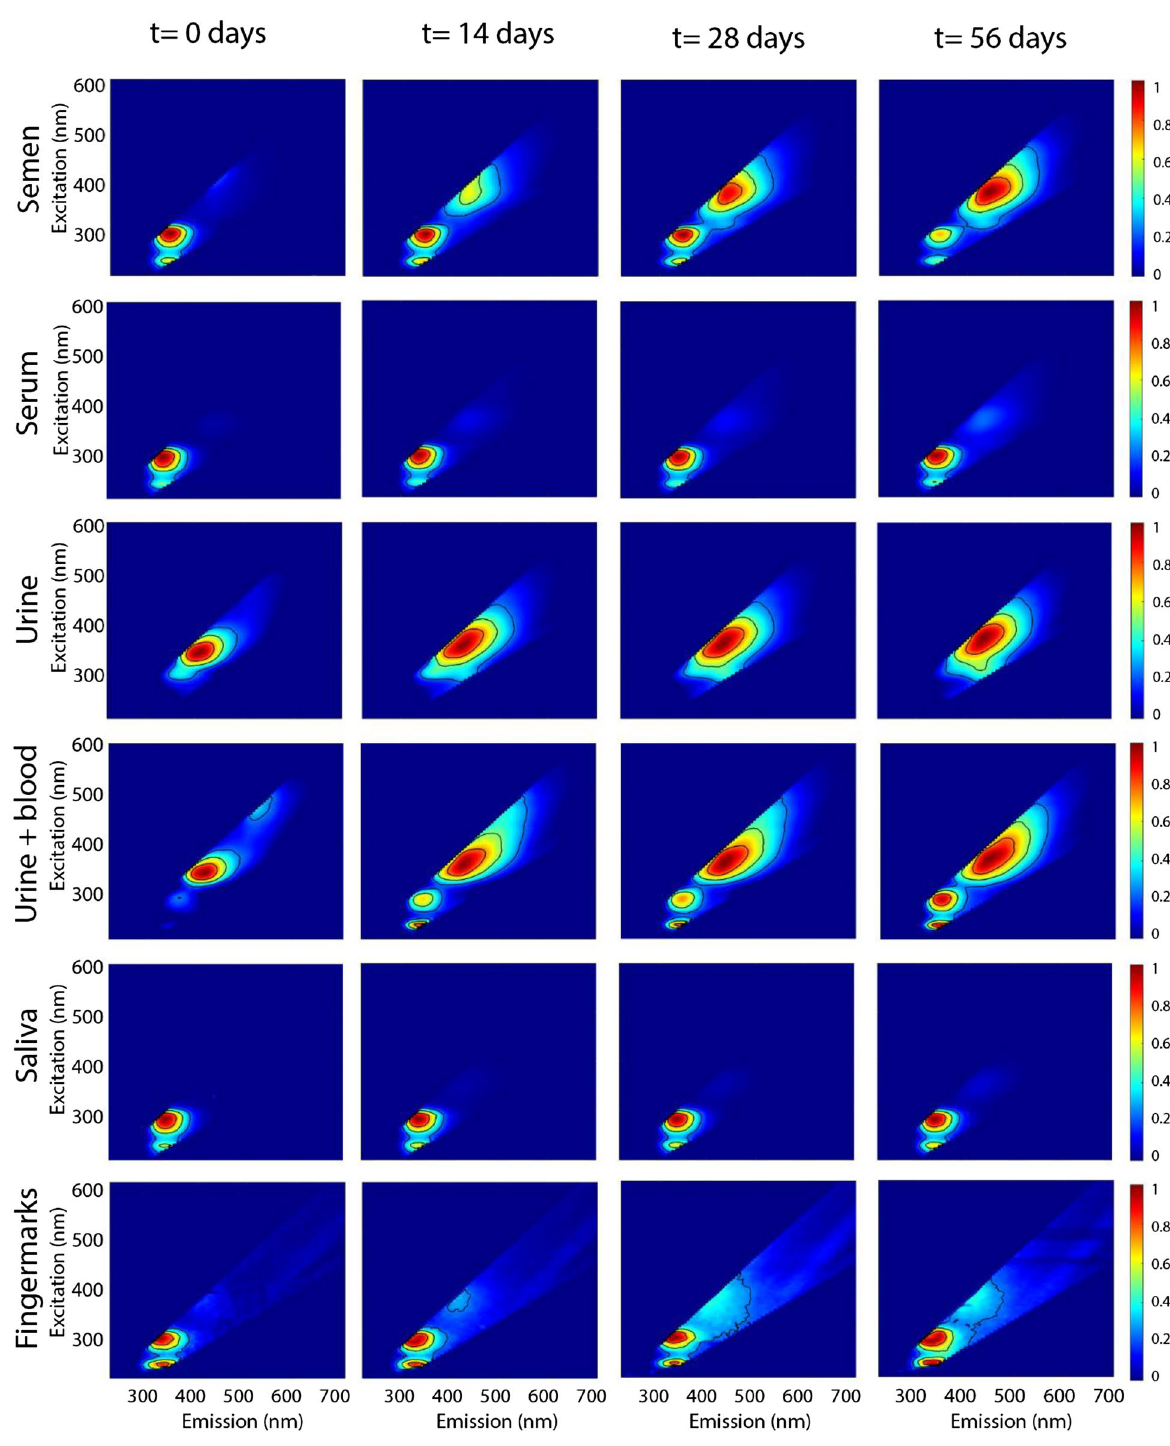
Figure 1. Normalized excitation and emission map of five different body fluids. The EEMs demonstrate the fluorescent properties and temporal behavior of semen, serum, urine, urine containing menstrual blood and fingermarks. In this figure the time points that were included are t = 0, t = 14, t = 28 and t = 56 intensities of the peaks at 285/330–400 nm and at 365/400–500 nm decreases over time until no further reac- tion kinetics could be observed. Note that especially at t = 0 the differences in ratio between the body fluids is large, while over time this difference gets smaller. For saliva, urine and fingermarks the variation in ratio among donors is larger than for semen and serum. More variation between the donor samples were expected for these body fluids, because they contain exogenous compounds from e.g. food, cosmetics or medicines, that could con- tribute to the Protein and FOX fluorescence. In combination with the results in section “Excitation and emission